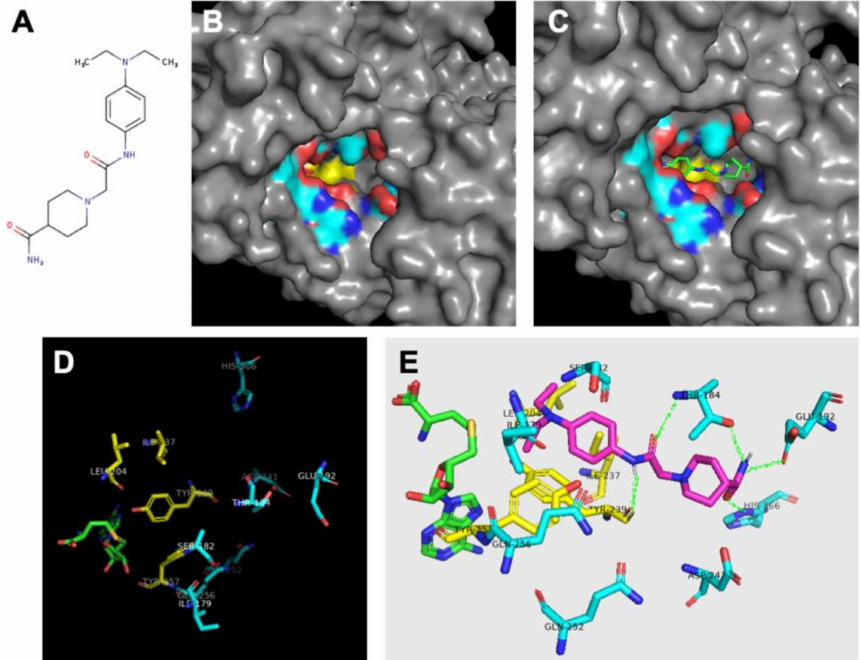
Figure 9. The binding pocket of SMYD3 and predicted inhibitor 4 interactions. Hydrophilic amino acids are light blue and hydrophobic amino acids are yellow. ( A ) Inhibitor 4 structure; ( B ) Hydropho- bic binding pocket indicated by a surface model; ( C ) Inhibitor 4 in binding pocket; ( D ) Amino acid residues in binding pocket, with hydrophobic interactions in yellow interacting with SAH in green, followed by a ring of blue hydrophilic residues; ( E ) Magenta inhibitor 4’s projected interactions with residues in binding pocket and the H-bonds shown in green. Image licensed by CC-BY 4.0 Ref. [32].